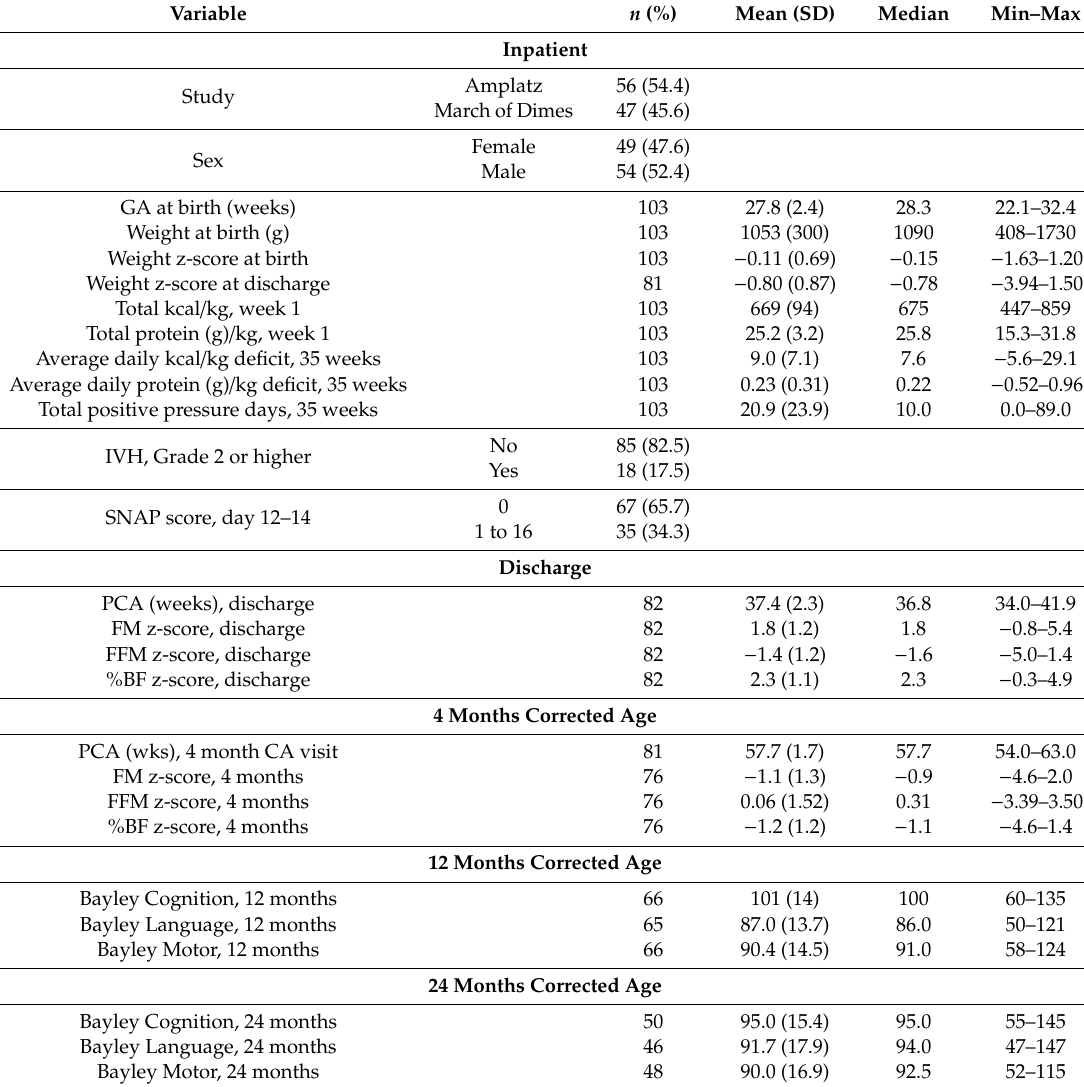
Table 1. Description of 103 VLBW preterm